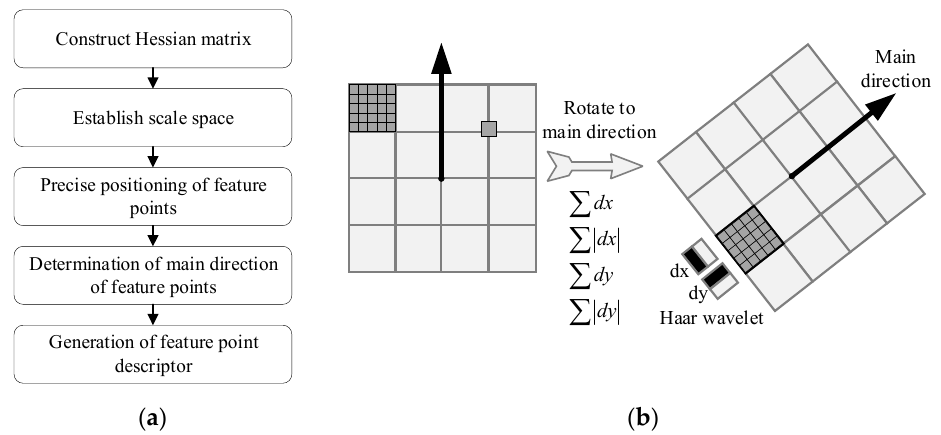
Figure 4. Feature point extraction and representation of SURF. ( a ) SURF feature point extraction and representation process; ( b ) SURF descriptor generation process.